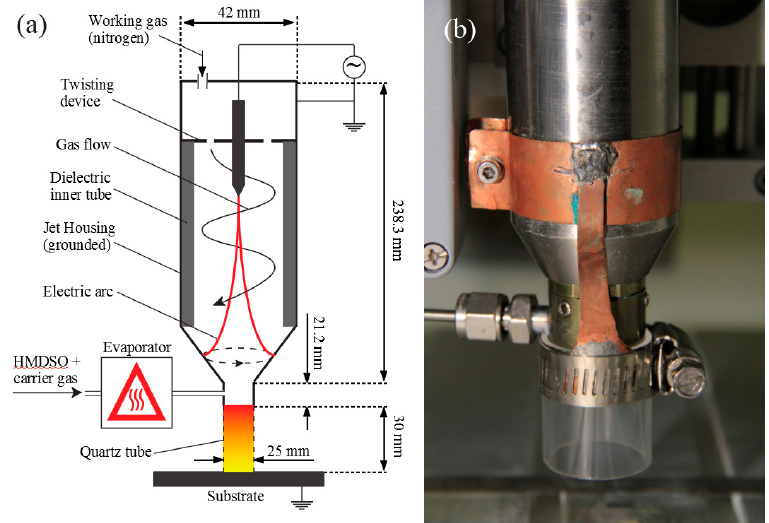
Figure 1. ( a ) Schematics of the modified atmospheric pressure plasma jet (APPJ) used in this study and ( b ) a closer look at the modified plasma jet.